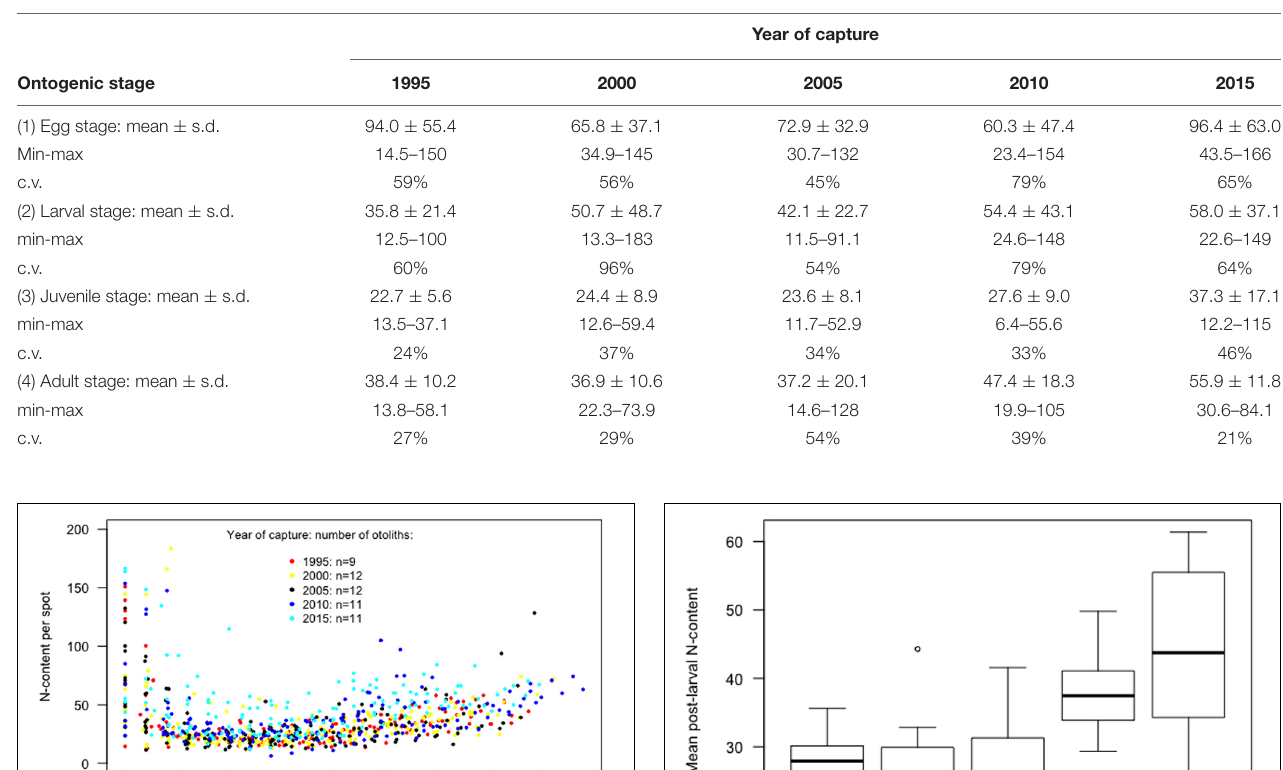
TABLE 2 | The mean ( ± s.d.), minimum and maximum values, and c.v. of NPS per year of capture and ontogenic stage.